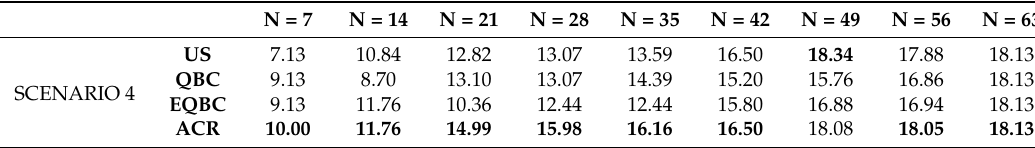
Table 4. LEI ( k -NN) in Scenario 4 (%).